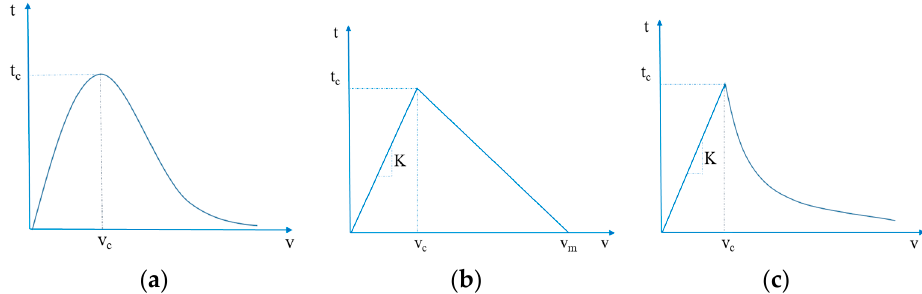
Figure 4. The shape of the cohesive laws used in this work: ( a ) exponential law; ( b ) bilinear law; ( c ) linear exponential law.